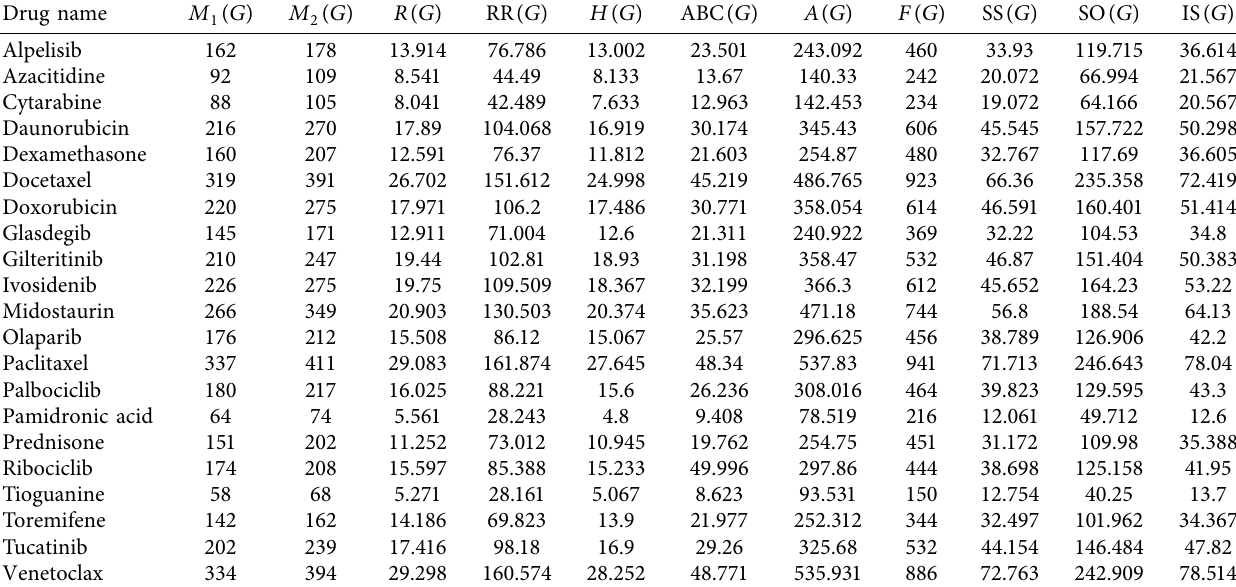
Table 1: Computed values of topological indices for breast cancer